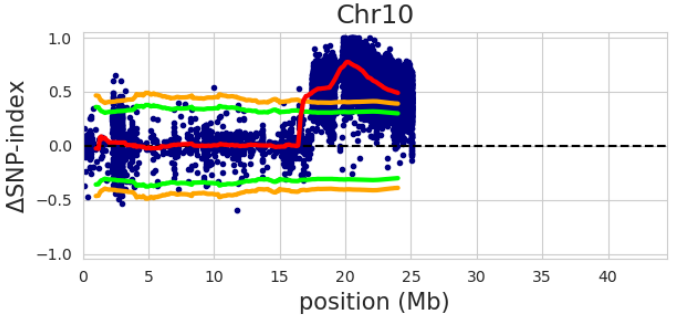
presented as mean ± SD in triplicate.